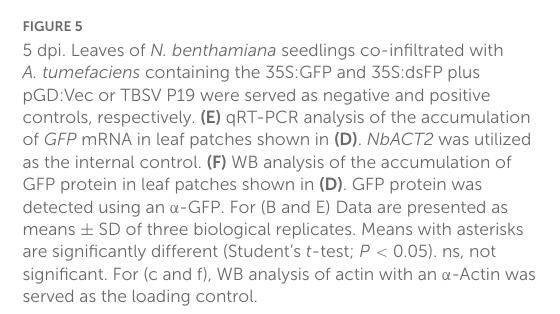
FIGURE5 5 dpi. Leaves of N. benthamiana seedlings co-infiltrated with A. tumefaciens containing the 35S:GFP and 35S:dsFP